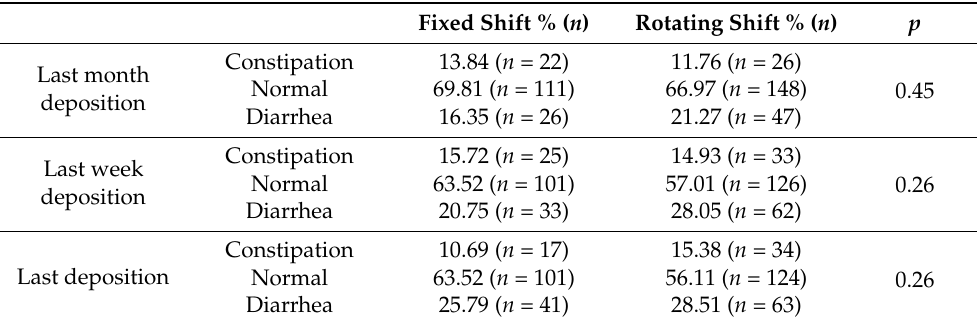
Table 4. Bristol